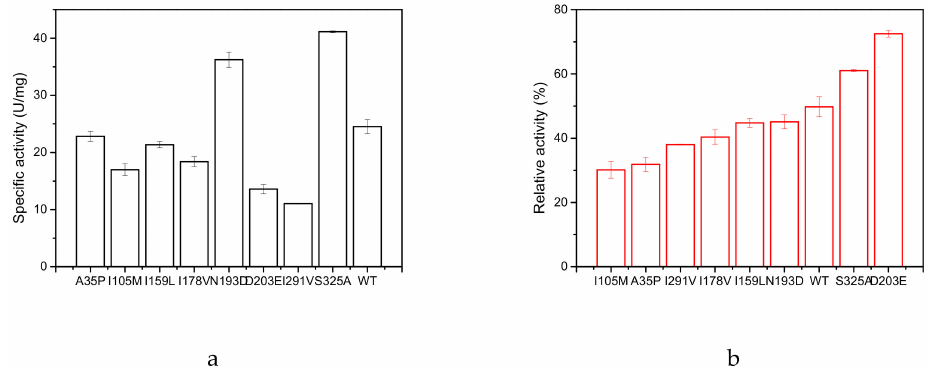
Figure 2. Specific activity and its inactivation profile of wild type (WT) and its mutants. ( a ) The specific activity of wild type and its mutants. ( b ) The residual activity of wild type and mutants after incubation at 60 ◦ C for 20 min. The enzyme activity of each without heat treatment was assumed to be 100%.